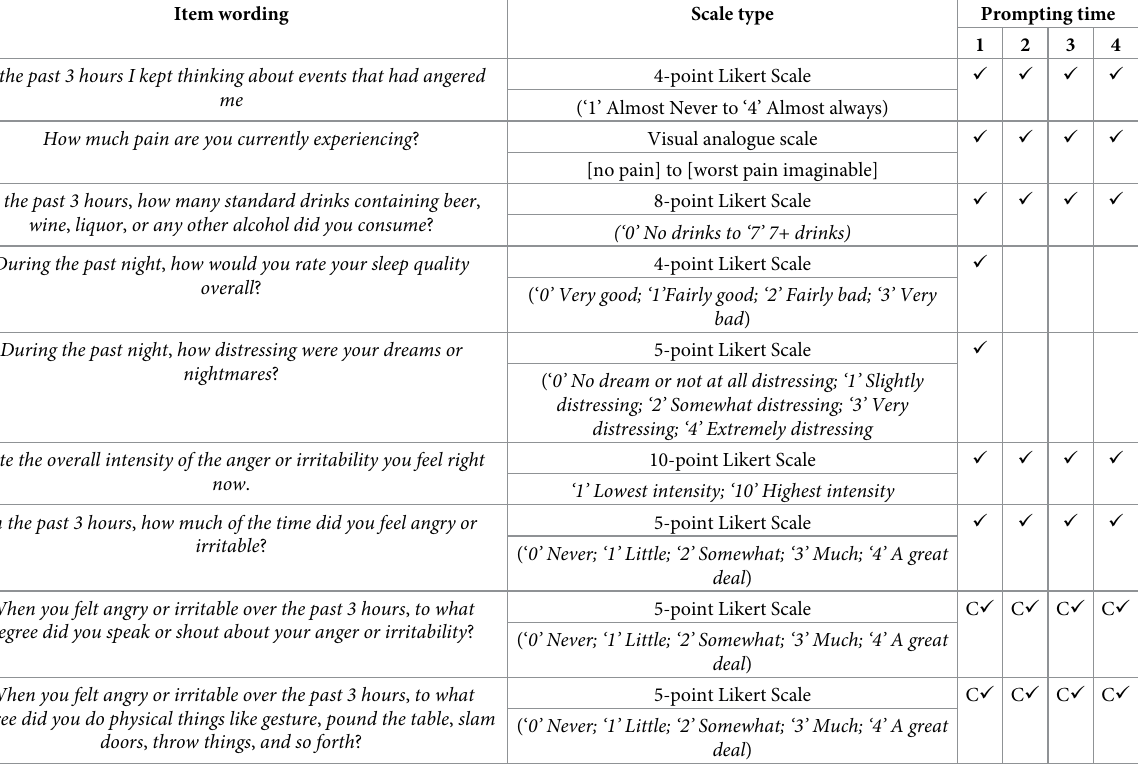
Table 2. Overview of EMA measurements.